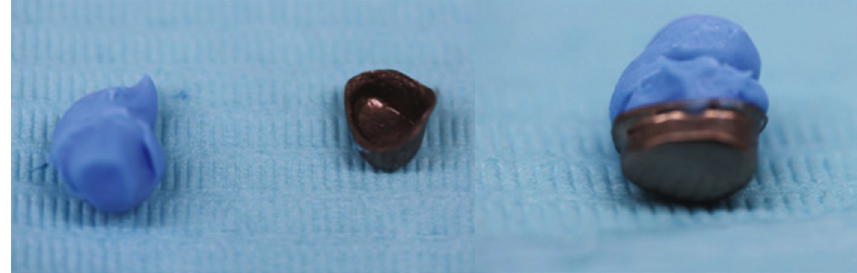
Figure 25: Index of the intaglio surface of the primary